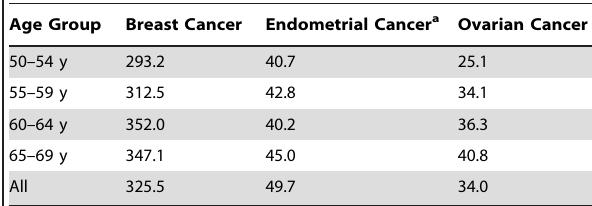
Table 3. Age-specific incidence per 100,000 person-years in non-Hispanic white women from the NHS cohort, ex luding only women with prevalent cancer of interest and no positive follow-up time.